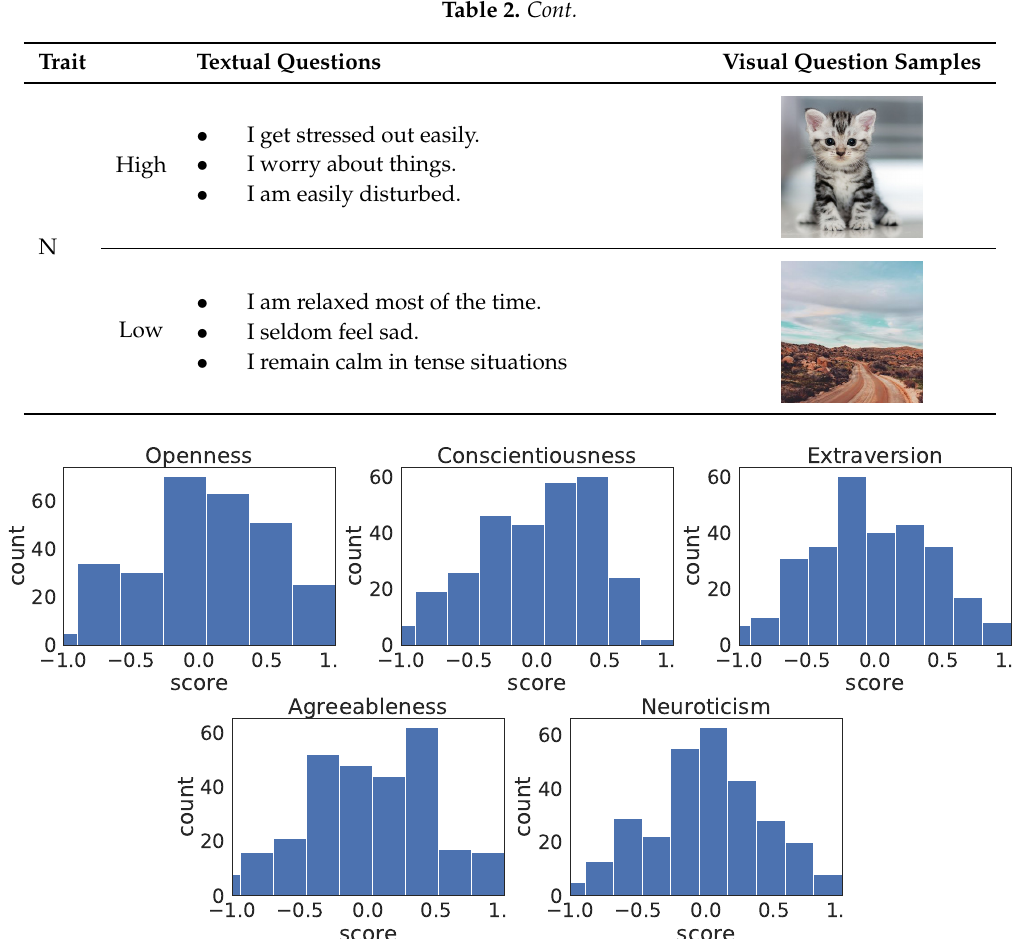
Figure 3. Histograms with the distribution of scores on the personality questionnaires for each of the big five personality traits. Scores have been normalized to be between − 1 and 1.